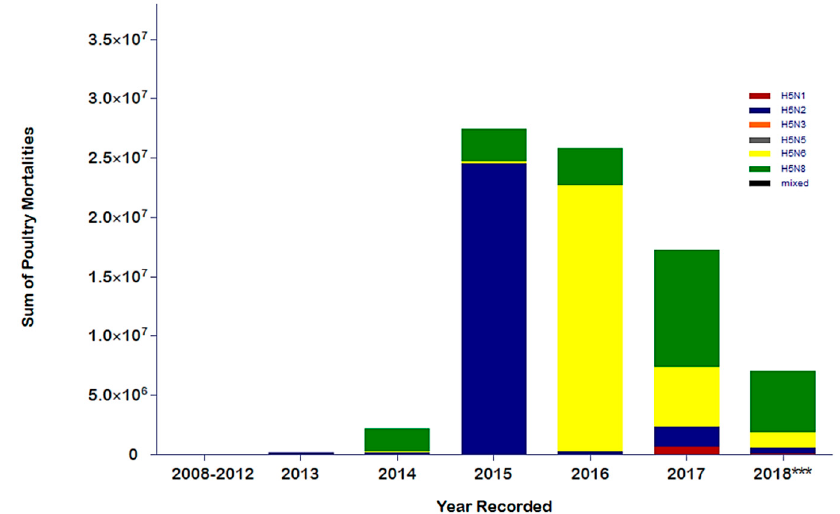
Figure 3. Epi curve of the cumulative sum of mortalities a recorded due to H5Nx from 2008 to June 2018. The data were generated based on the downloaded data from the FAO’s Global Animal Disease Information System, Empress-I (http://empres-i.fao.org/eipws3g/) [58]. *** For 2018, it should be noted that some of the poultry mortalities from the African region in 2018 were not all reflected from the collated Empress-I data. a Cumulative poultry mortalities is the total sum of all the mortalities including the number of dead, slaughtered, and destroyed due to the specified disease cause during the specified period.